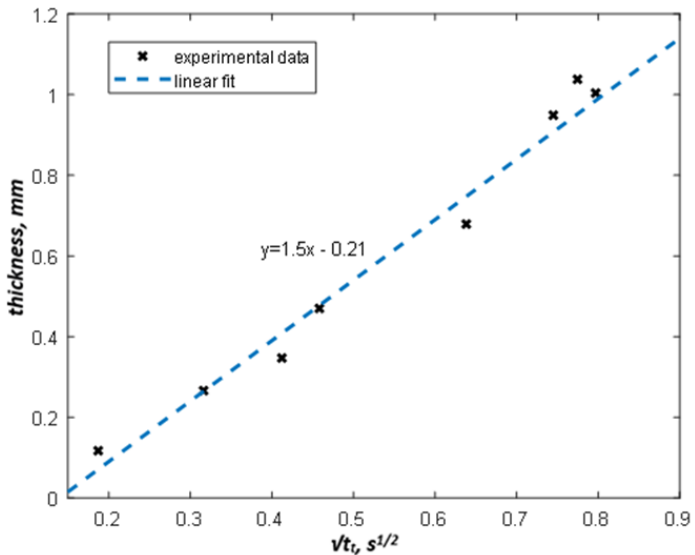
Figure 8. Experimental dependence of square root of threshold time vs. coating thickness.